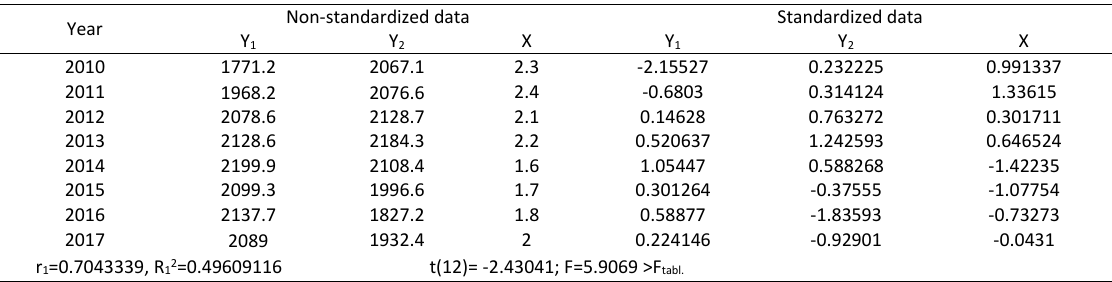
Table 5: Data for construction of regression model of food provision at consumer market and capital investment in agriculture of Ukraine in 2010-2017 (State Statistics Service of Ukraine, 2018b; State Statistics Service of Ukraine, 2018f; State Statistics Service of Ukraine, 2018c)